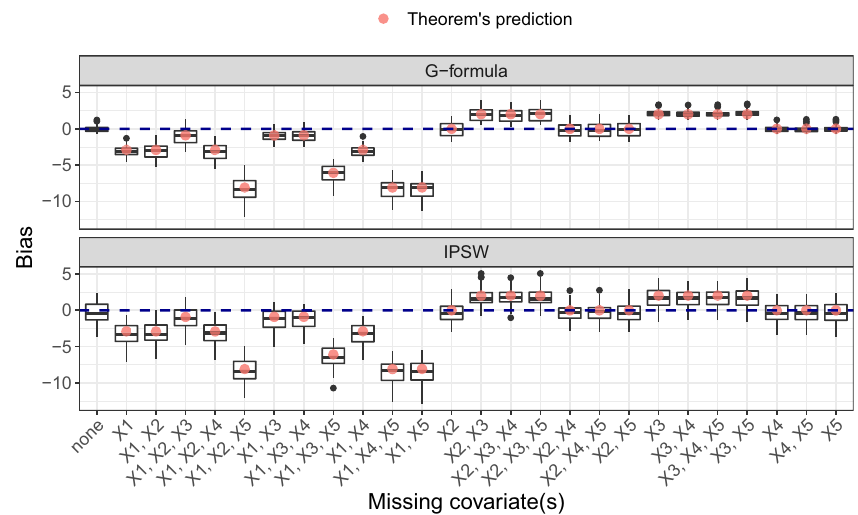
Figure 4: Illustration of Theorem 1: Simulation results for the linear model with missing covariate ( s ) when generalizing the treatment e ff ect using the G - formula ( De fi nition 1 ) or IPSW ( see De fi nition A1 in appendix ) estimators on the set of observed covariates. Missing covariate are indicated on the x - axis. The theoretical bias ( orange dot ) is obtained from Theorem 1. Simulations are repeated 100 times.